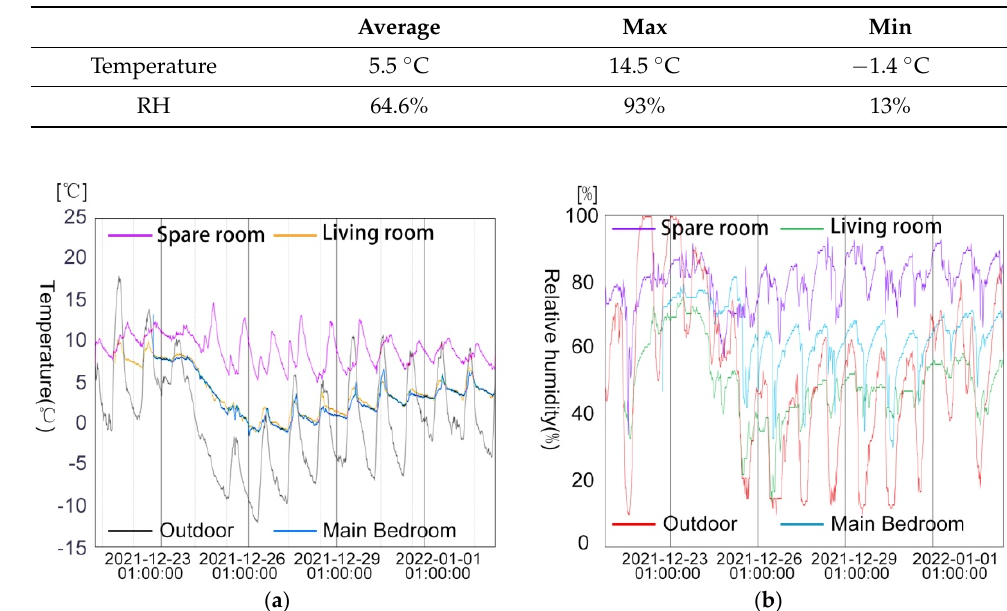
humidity. humidity.